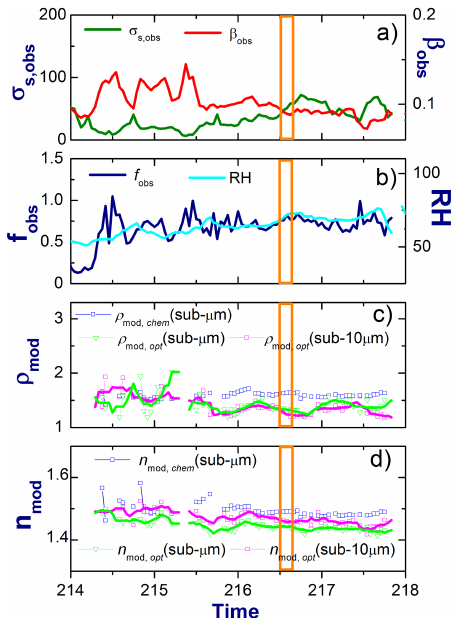
Figure C2. The same as Fig. 6 but for selected wet period (56 points, RH = 64.2 ± 6.3). The vertical orange bar represents a sub- period where the optical properties of wet particles (Fig. C2) are comparable with those obtained their dry counterparts (Fig. C1), but values of the RH are very